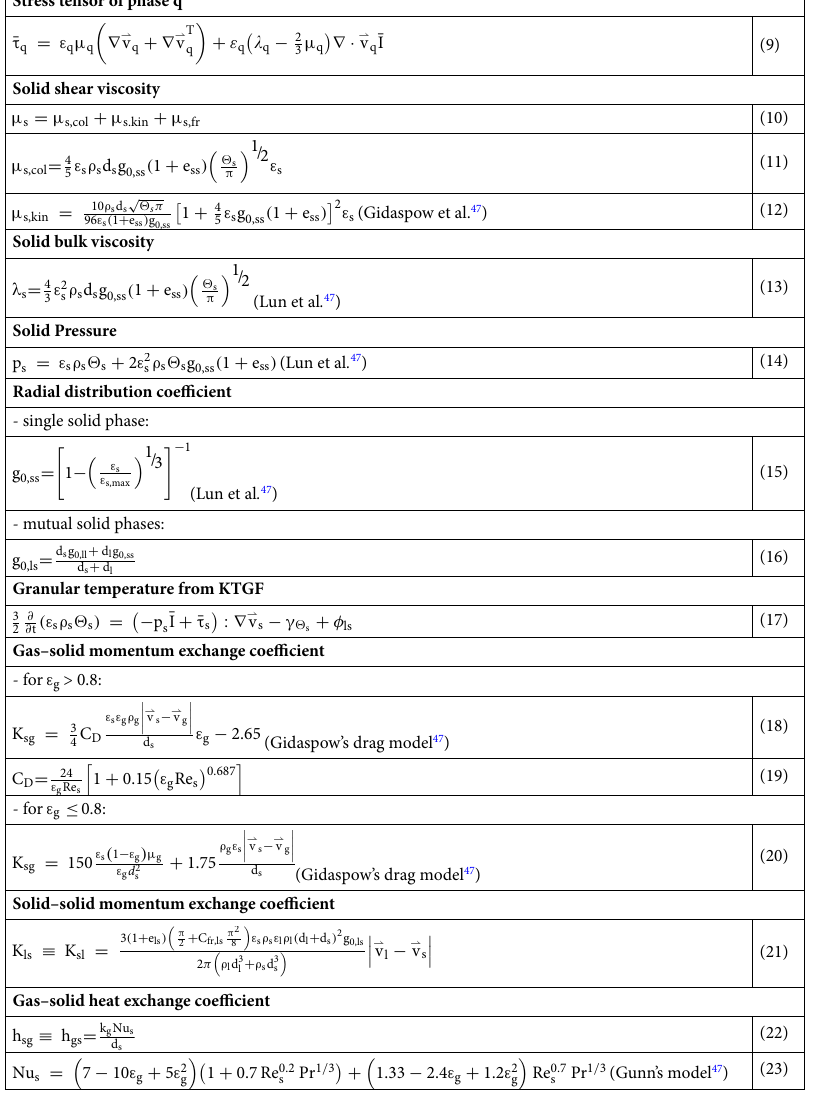
Table 2. Constitutive models.